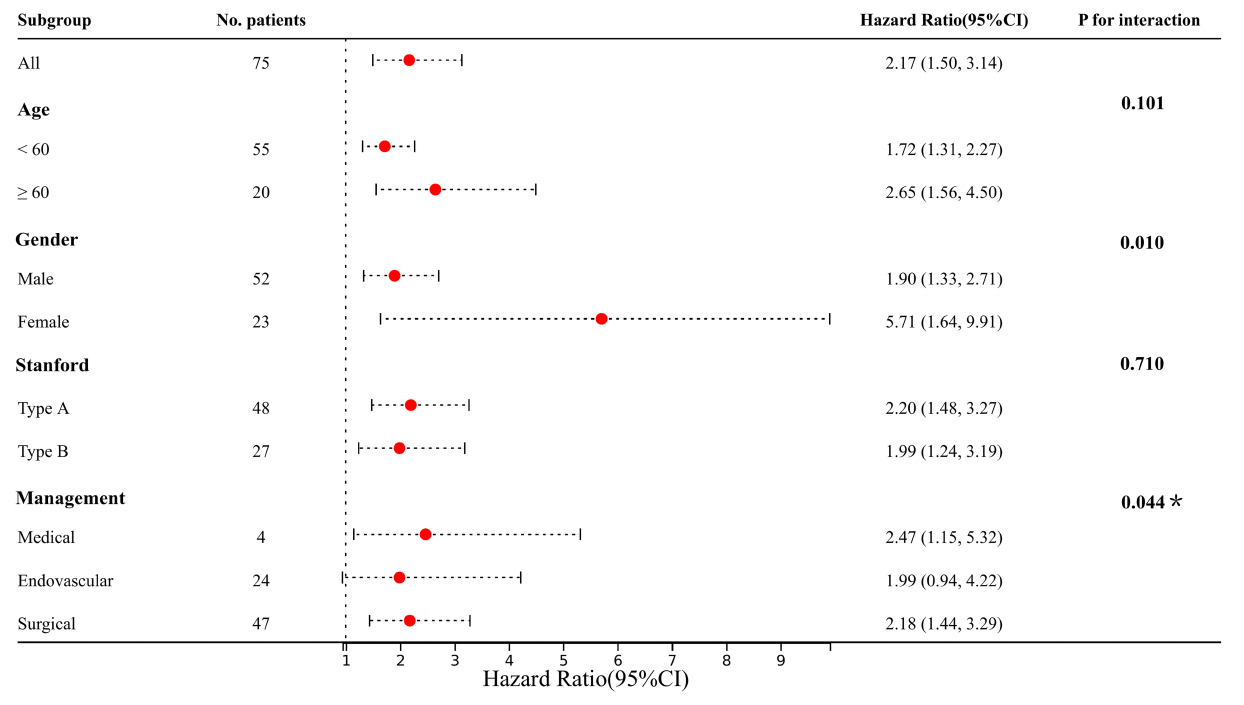
FIGURE 4 | Results of subgroup analysis and interaction analysis between LPA and CKD (LPA per 10 increments). Adjusted: age, gender, hypertension, diabetes, CHD, valvular disease, COPD, stroke, OSA, Marfan syndrome, smoking, drinking, medication history of aspirin, clopidogrel, statins, and hormones. * P -value for the management is for the comparison of patients treated medically with patients treated